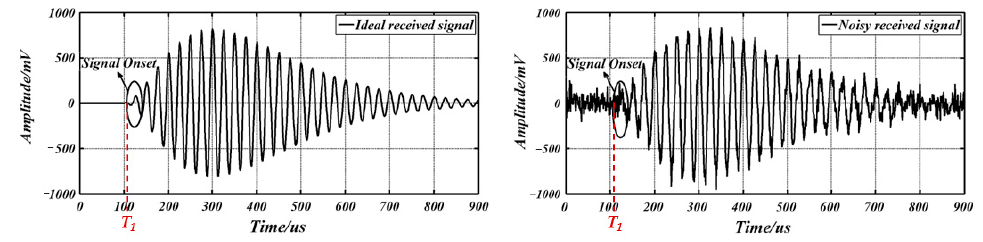
Figure 6. Ideal and noisy ultrasonic echo signals [90].